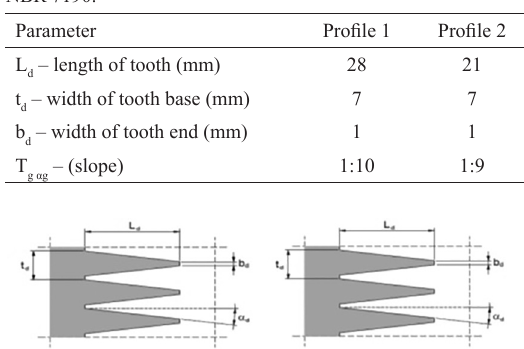
Figure 2: Geometric parameters for finger joints of the finger- joint type 5 .